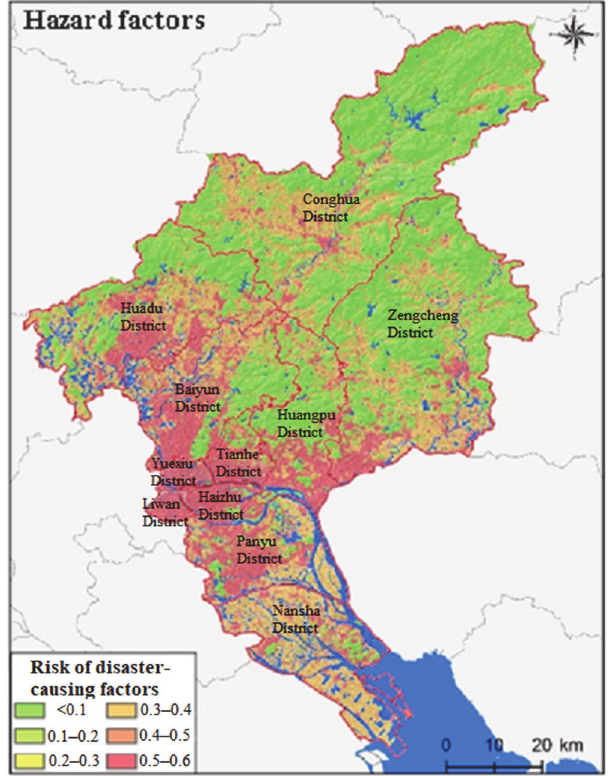
Figure 7. Spatial distribution of hazard factors in Guangzhou.